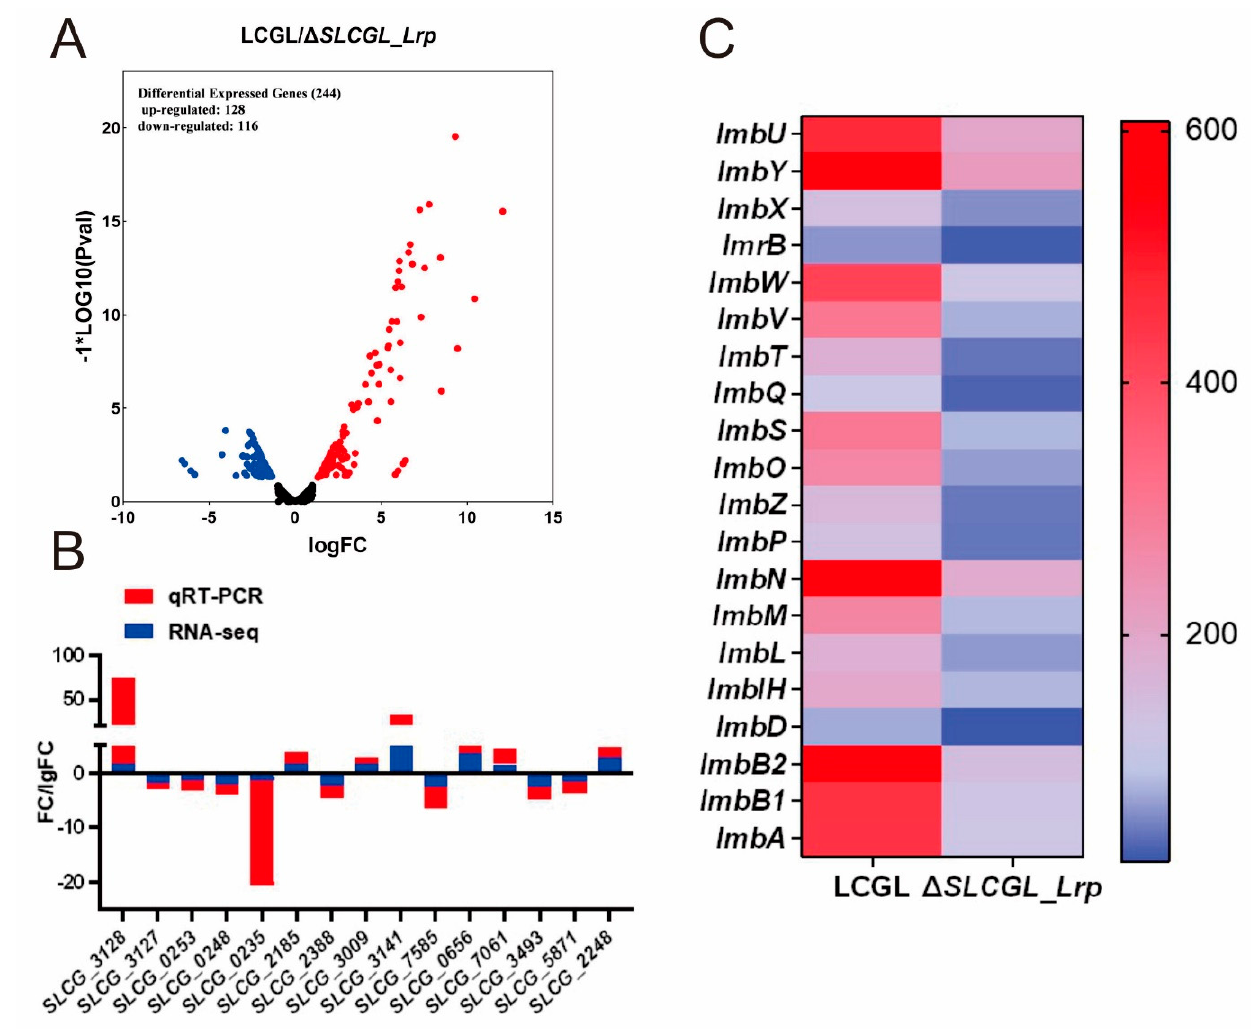
Figure 1. Comparative transcriptome analysis of LCGL and ∆ SLCGL_Lrp . ( A ) Volcano blots to show significant changes in gene expression between LCGL and ∆ SLCGL_Lrp . Dispersion graph of the − log10 ( p value) (y axis) against the log2 (fold change) (x axis) corresponding to the genes by their differential expression. The red dot shows upregulated DEGs, the blue dot indicates downregulated DEGs, and the dark gray dot is a non − significant differential. ( B ) Comparison of gene expression pa tt erns obtained using RNA − seq and RT − qPCR. ( C ) Heat map of gene expression within the lincomycin biosynthetic gene cluster.